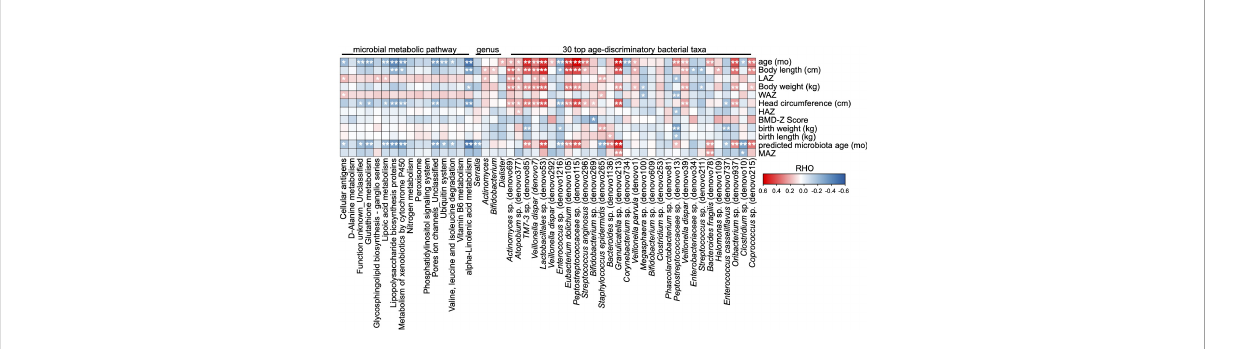
FIGURE 5 Correlations between the gut microbial taxa/functions and infant anthropometric features. The heatmap of the correlations between the signi fi cant altered gut microbial taxa/functions and the anthropometry features. Based on Spearman ’ s correlation coef fi cient, * p < 0.05, ** p <